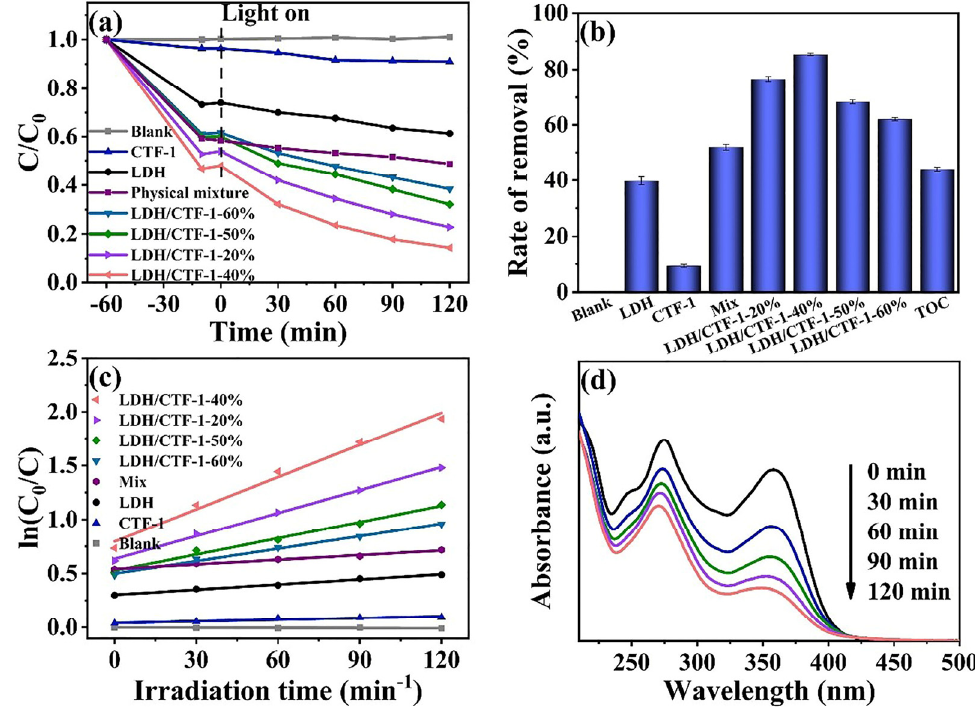
Figure 7. ( a ) Photocatalytic degradation TC curves; ( b ) removal rate of TC solution; ( c ) first-order- kinetic plots of TC degradation; and ( d ) time-dependent UV-vis spectra of TC solution for the LDH/CTF-1-40%